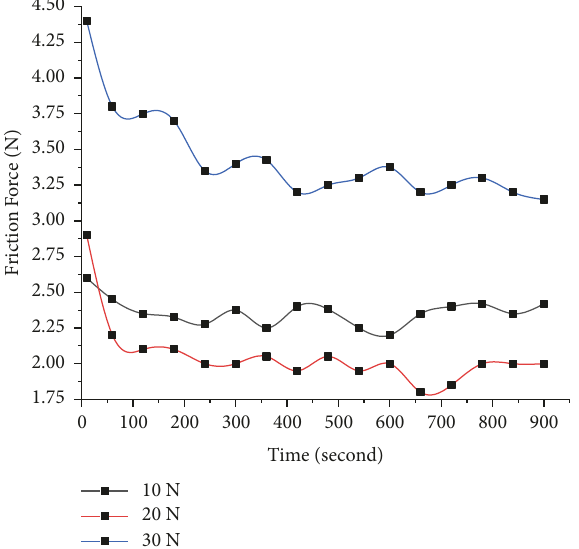
Figure 11: Frictional force varying with time of contact for 20% Al 2 O 3 .